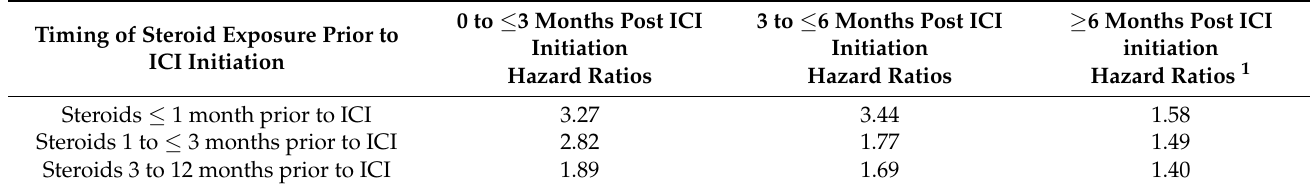
Table 4. Assessment of the robustness (using E-values 1 ) of observed associations for all-cause mortality with steroid exposure presented in Figure